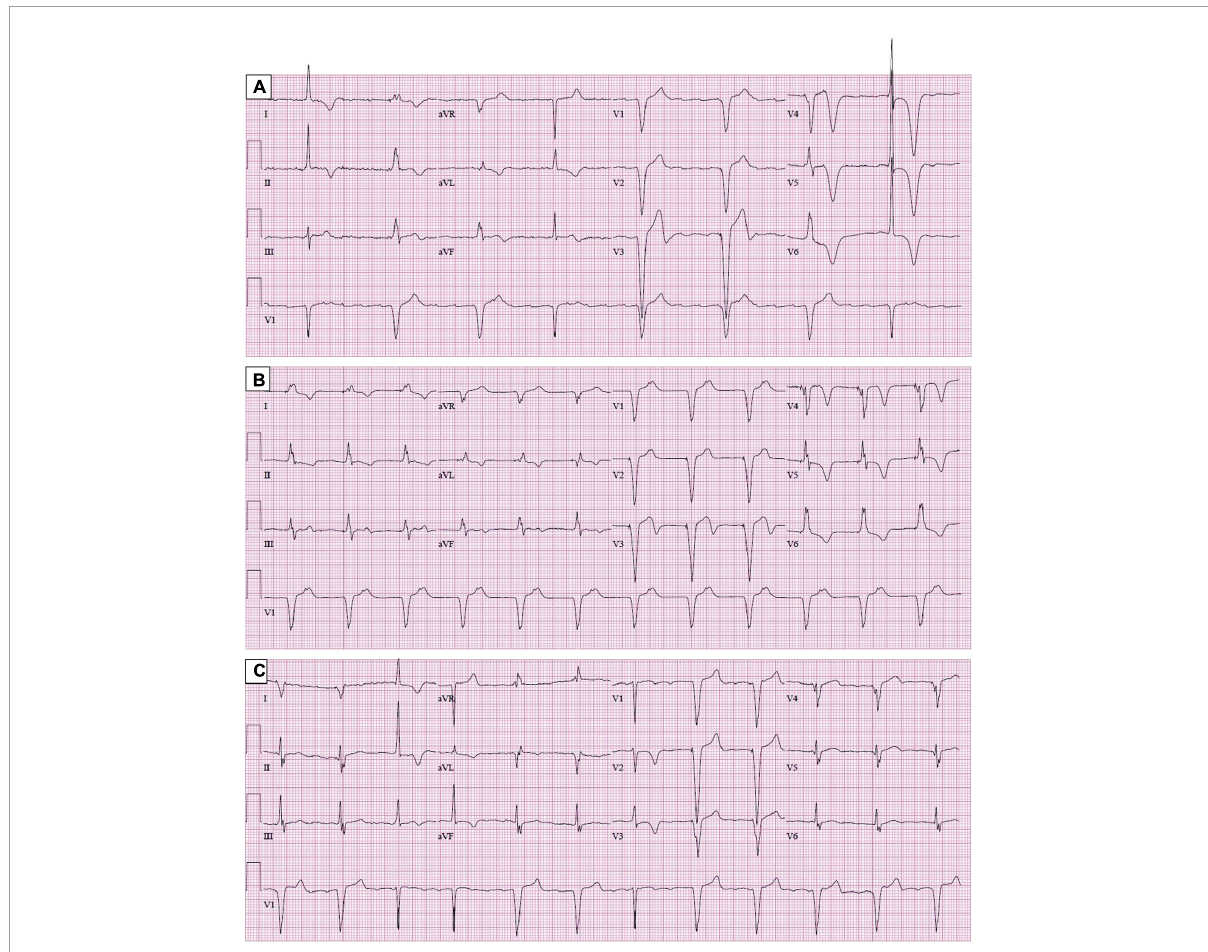
FIGURE1 Electrocardiogram. Panel (A) shows tall R waves and giant-negative T waves in V4–V6. Panels (B) (8 months later) and (C) (24 months later) show a progressive decrease in the amplitude of the R waves and T wave inversions in the paced beats in precordial